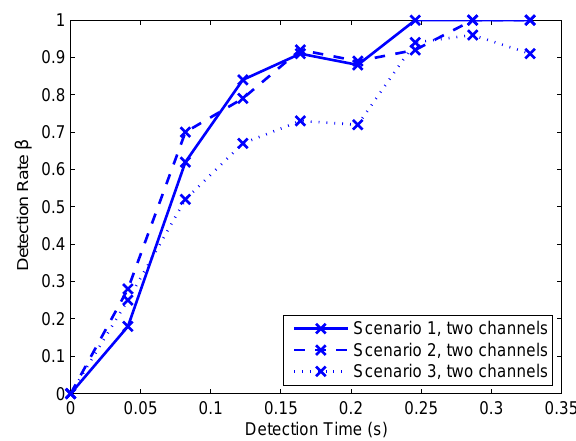
Figure 15. ROC curves in Scenario 3 under different SNR conditions in the cases of two channels and four channels,